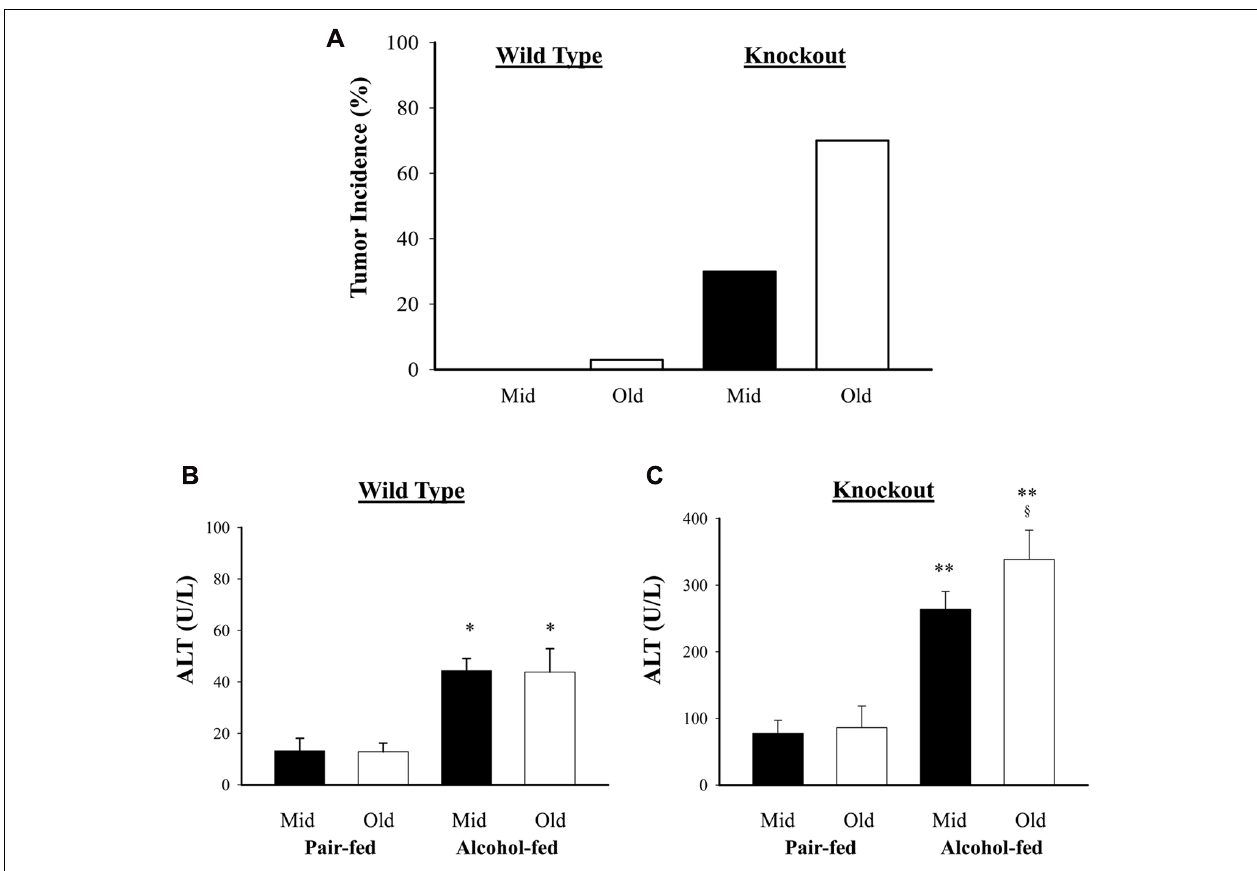
FIGURE 1 | Effects of alcohol on liver tumorigenesis in mice under constitutive endoplasmic reticulum (ER) stress. Female mice at age of 6–8 months (Mid) and at age of 14–16 months (Old) were fed alcohol respectively for 12 months. (A) Liver tumor occurrence in mice fed alcohol and high fat